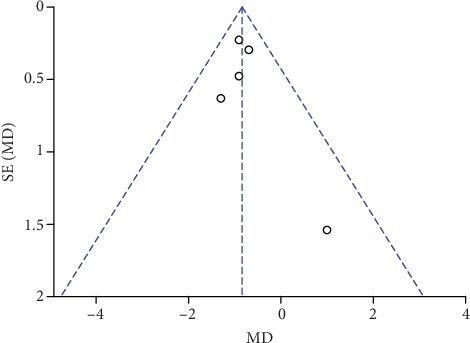
Funnel plot of pain scores during movement at 24 h.